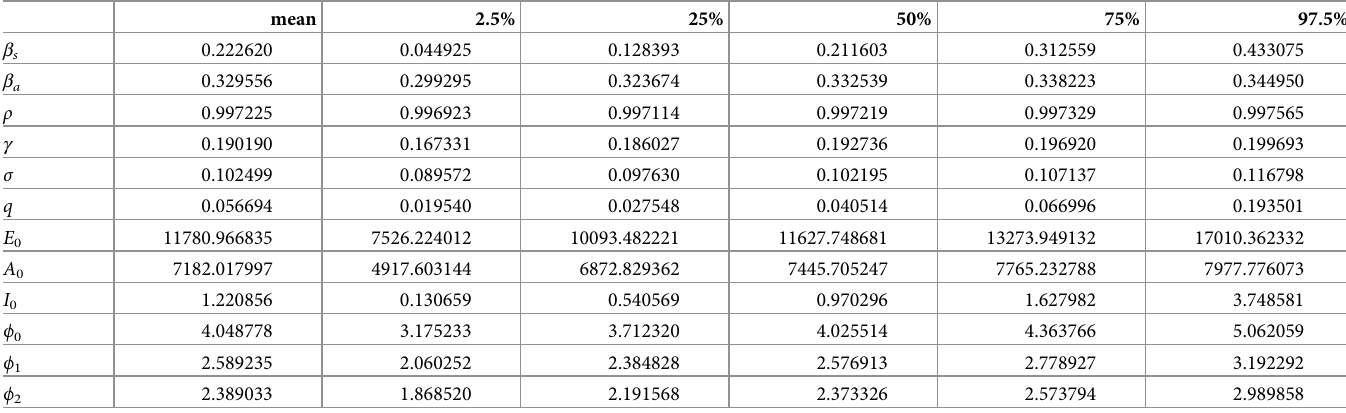
Table 2. Estimation of the parameters of the model (1).